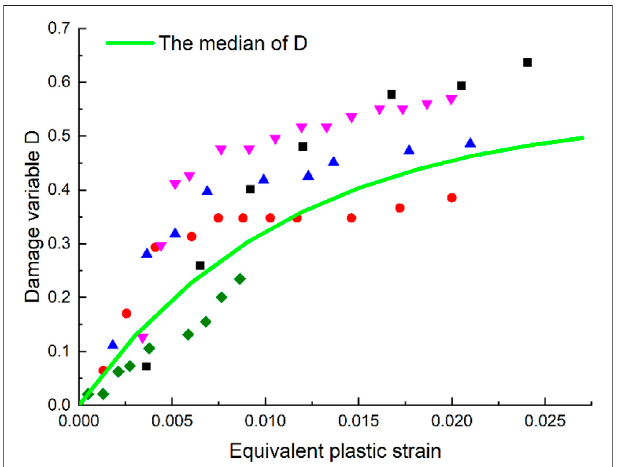
FIGURE 10 | The median curve regarding damage variables of specimens